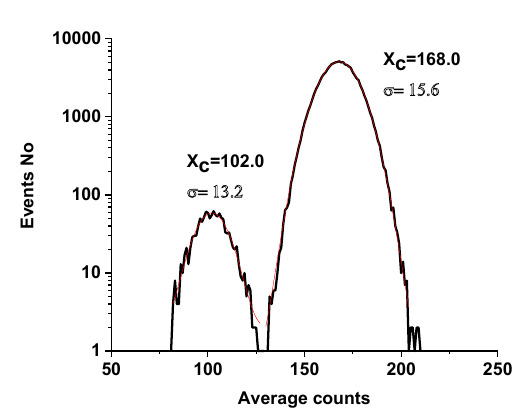
Fig. 5. Distribution of a number of neutrons detected in the set of 200 bursts .